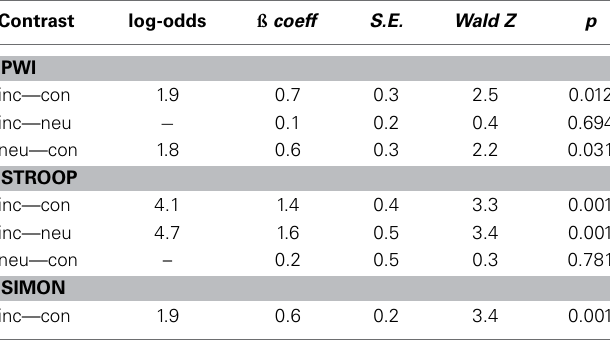
Table 2 | Results of the logistic regression analysis on the errors for the three tasks.